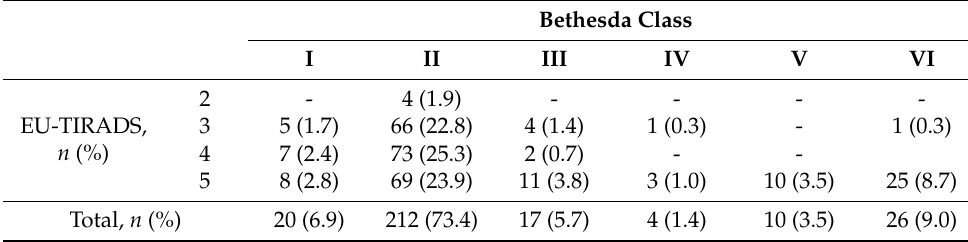
Table 2. Summary of EU-TIRADS categories by Bethesda classes.